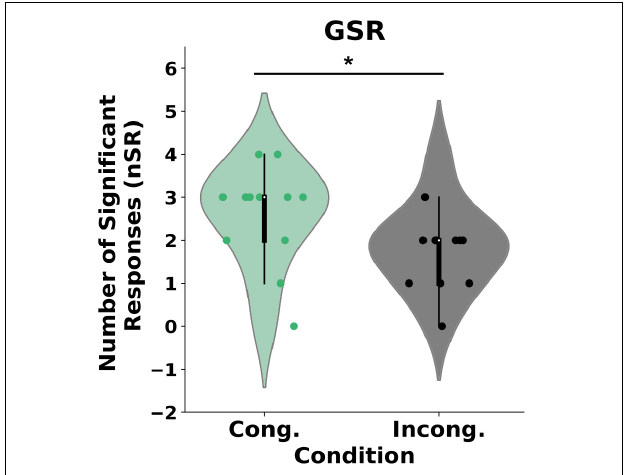
FIGURE 3 | GSR results. The plot represents the difference between the groups in the number of galvanic skin responses (nGSR) post stabbing event. * P < 0.0.